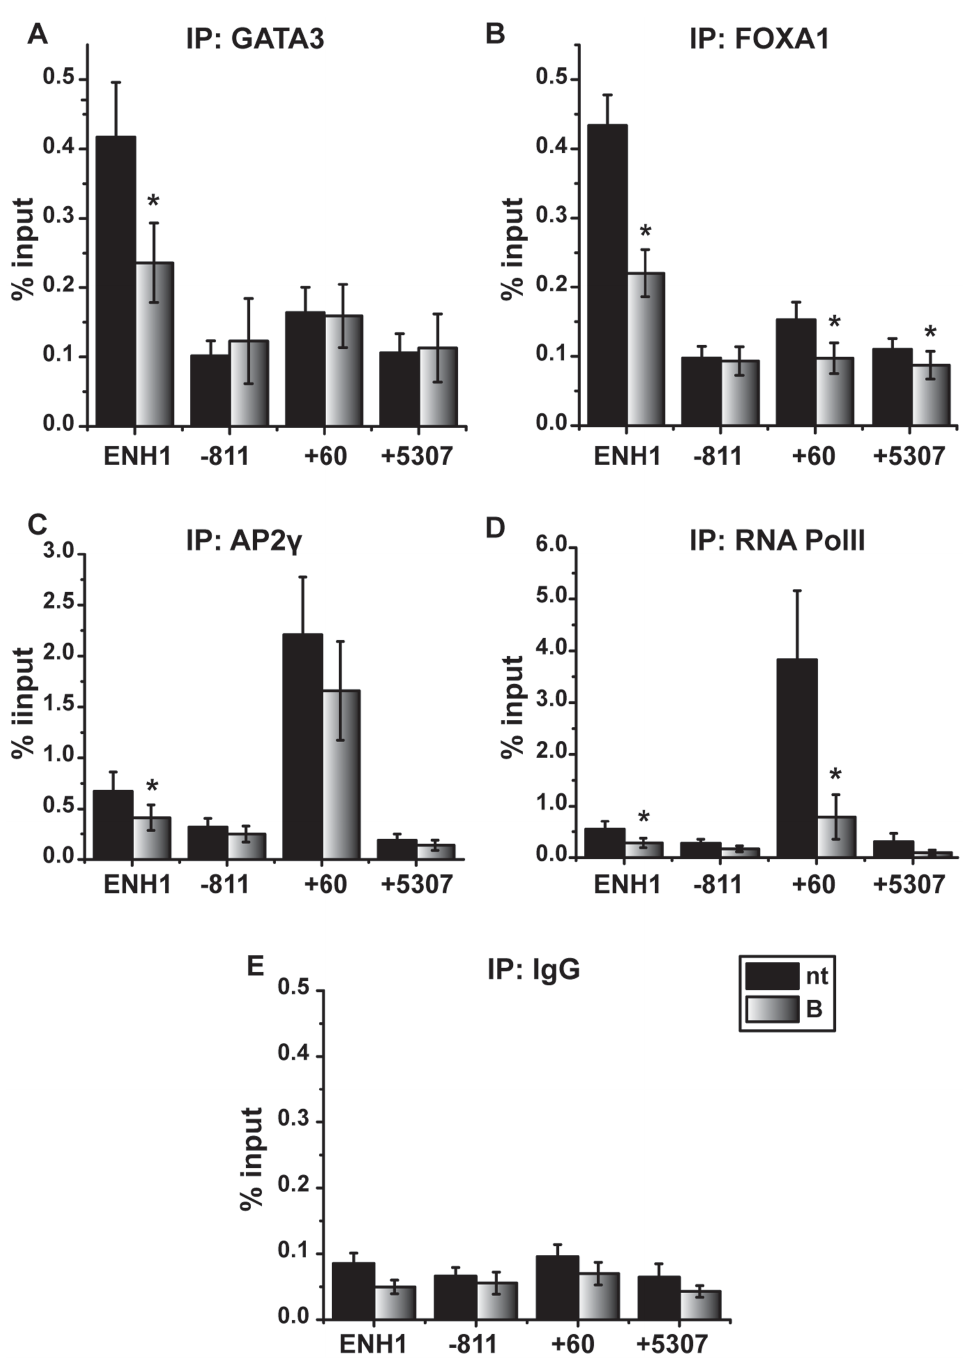
Figure 3. Proteasome inhibition decreases transcription factor occupancy on the ESR1 enhancer and promoter. MCF7 cells were treated with vehicle (nt) or 30 nM bortezomib (B) for 24 hours and ChIP analyses were performed to examine occupancy at regions of ESR1 depicted in the diagram in Fig. 2A. Data representing a minimum of three independent experiments are presented as percent of input sample for A ) GATA3, B ) FOXA1, C ) AP2 c , D ) RNA PolII, and E ) IgG (control) on the indicated regions. Data are shown as mean 6 SEM. Statistical analysis comparing untreated and bortezomib-treated groups were performed using a Student’s paired t-test. Statistically significant differences of p , 0.05 are indicated with an asterisk (*). parameters included a 5 minute initial denaturation step at 95 u C Ribosomal P0 mRNA served as the internal control. Each well followed by 40 cycles of denaturation at 95 u C for 15 seconds and contained 1x Sybr Green Master mix (Biorad), 10 ng of cDNA, combined annealing, and elongation steps [25]. A melt curve step and 100 nM of the indicated primer pair in final volume of 20 m L. was performed to ensure the amplification of a single product.